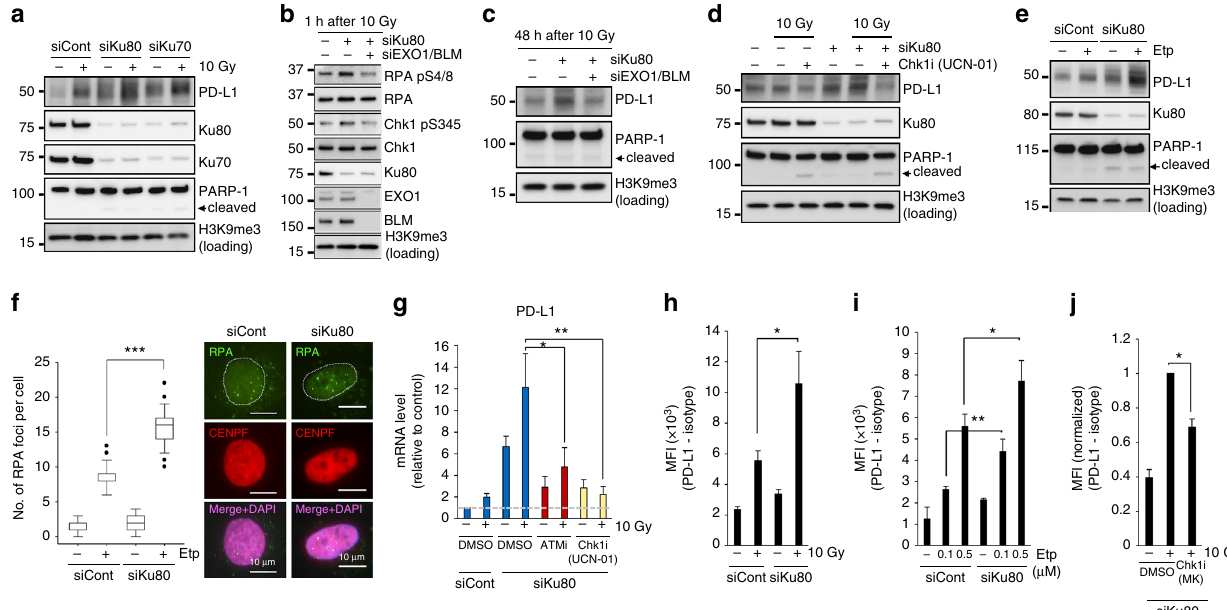
Fig. 5 Depletion of Ku complex enhances PD-L1 expression after DSBs. a Depletion of either Ku80 or Ku70 substantially enhances PD-L1 upregulation after IR. U2OS cells were exposed to Ku80 or Ku70 siRNA. PD-L1 level was examined 48 h after 10 Gy. b EXO1/BLM is required for resection, which is determined by phosphorylation of RPA S4/8, in Ku80-depleted cells. The enhancement of Chk1 phosphorylation in Ku80-depleted cells requires EXO1/ BLM. U2OS cells were exposed to Ku80 siRNA with or without EXO1/BLM siRNA. The phosphorylation of Chk1 S345 and RPA S4/8 (a marker of resection) was examined 1 h after 10 Gy. c The enhancement of PD-L1 in Ku80-depleted cells requires EXO1/BLM. U2OS cells were exposed to Ku80 siRNA with or without EXO1/BLM siRNA. PD-L1 was examined 48 h after 10 Gy. d The enhancement of PD-L1 in Ku80-depleted cells requires Chk1 activity. U2OS cells were exposed to Ku80 siRNA. PD-L1 expression was examined in Ku80 siRNA cells with or without Chk1i (UCN-01) 48 h after 10 Gy. e Depletion of Ku80 substantially enhances PD-L1 upregulation after Etp treatment. PD-L1 level was examined 48 h after 100 nM Etp treatment. f The enhancement of DSB end resection in Ku80-depleted cells was shown by the greater number of RPA foci after 100 nM Etp treatment. The number of RPA foci in G2 cells were examined. G2 cells were identi fi ed by CENPF 45 . The scale bar represents 10 μ m. g ATM/Chk1 activity is required for the upregulation of PD-L1 mRNA in Ku80-depleted cells after IR. PD-L1 mRNA in Ku80-depleted U2OS cells with or without ATMi or Chk1i (UCN-01) was examined at 48 h after 10 Gy. h – j Depletion of Ku80 enhanced the upregulation of cell-surface PD-L1 after IR ( h ) or Etp ( i ). This upregulation requires Chk1 activity ( j ). Cell- represent the s.d. of three independent experiments ( g – j ). Statistical signi fi cance was determined using Student ’ s two-tailed